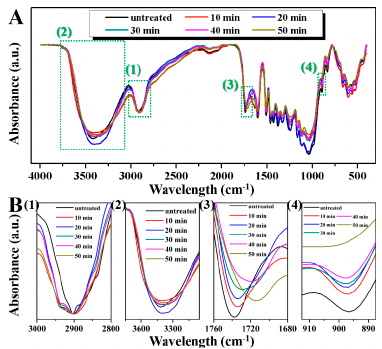
Figure 2. Complete ( A ) and partial ( B ) FTIR curves of the bamboo slices with 25% initial moisture content treated by saturated steam heat at 180 °C with different